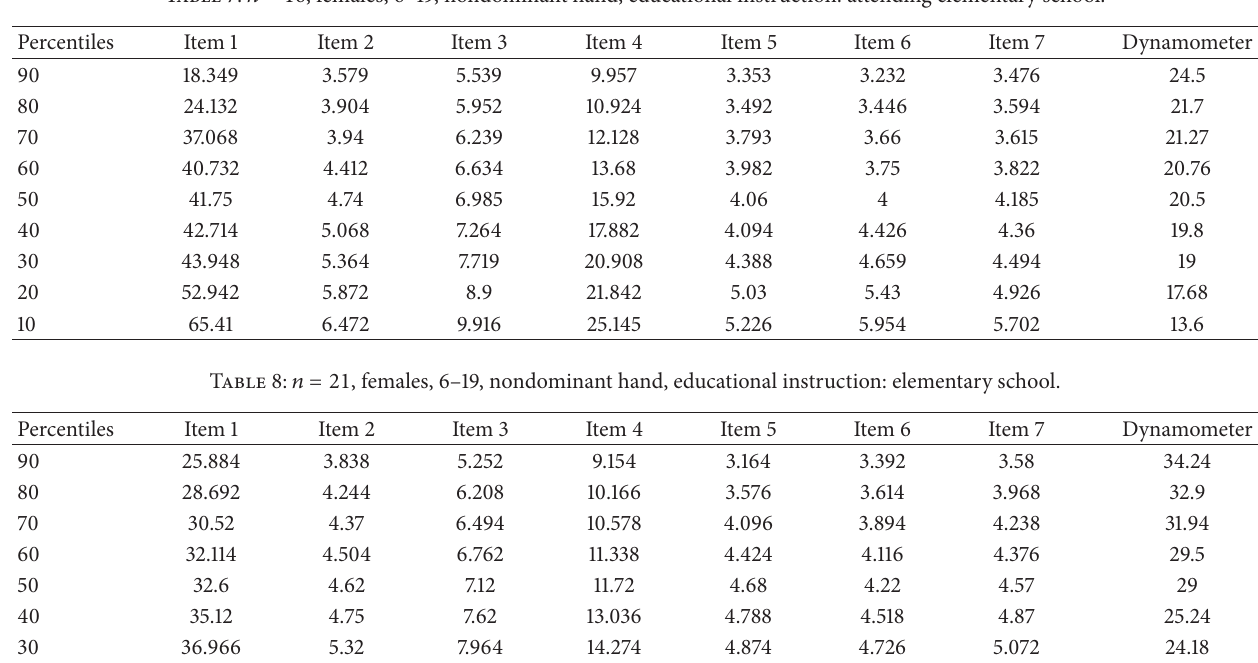
Table 7: 𝑛 = 16 , females, 6–19, nondominant hand, educational instruction: attending elementary school.